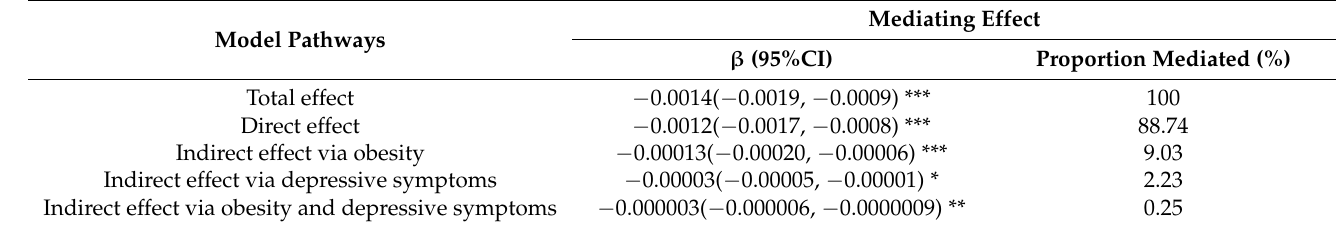
Figure 2. Association of HEI-2015 (X) and cardiovascular disease (Y) mediated by obesity (M1) and depressive symptoms (M2). a 1 represents the effect of M1 on X; a 2 represents the effect of M2 on X; b 1 represents the effect of Y on M1; b 2 represents the effect of Y on M2; d 21 represents the effect of M2 on M1; C represents the direct effect, and c’ represents the total effect. * Solid lines indicate statistically significant associations; dashed lines indicate no statistically significant associations. Adjusted for age and sex, race/ethnicity, education, marital status, poverty ratio, drinking status, work activities, and recreational activities. Table 5. The mediating proportion of obesity and depressive symptoms on the association between the HEI-2015 and the risk of cardiovascular disease.